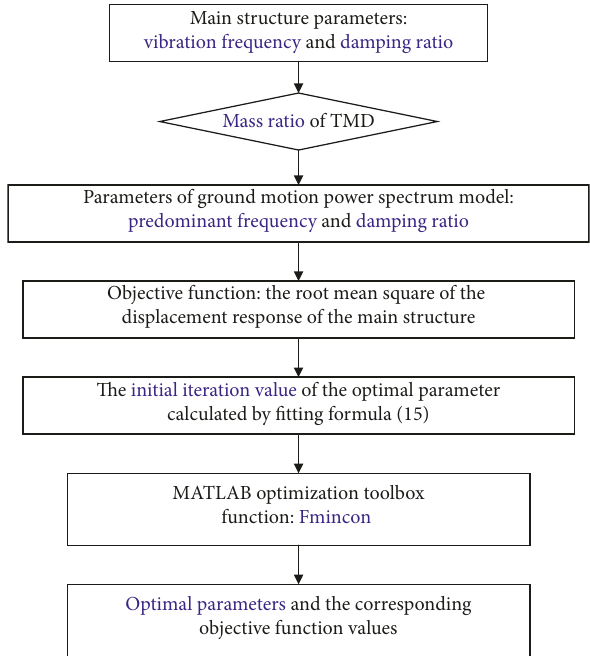
Figure 9: The numerical optimisation process of TMD parameters under filtered white noise excitations.